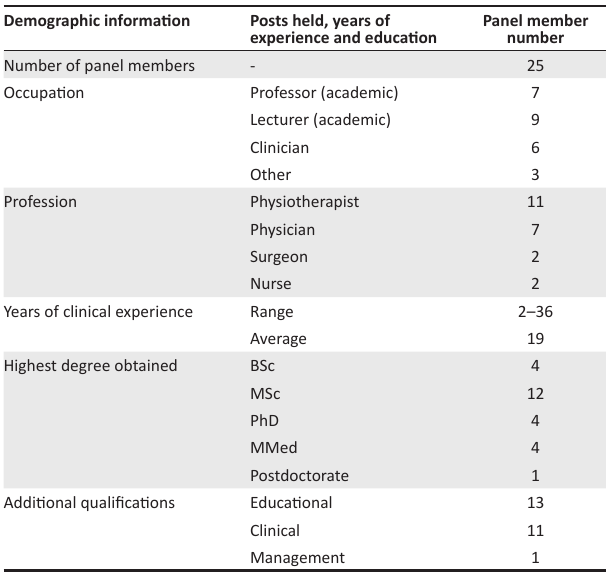
TABLE 1: Demographic information from the panel